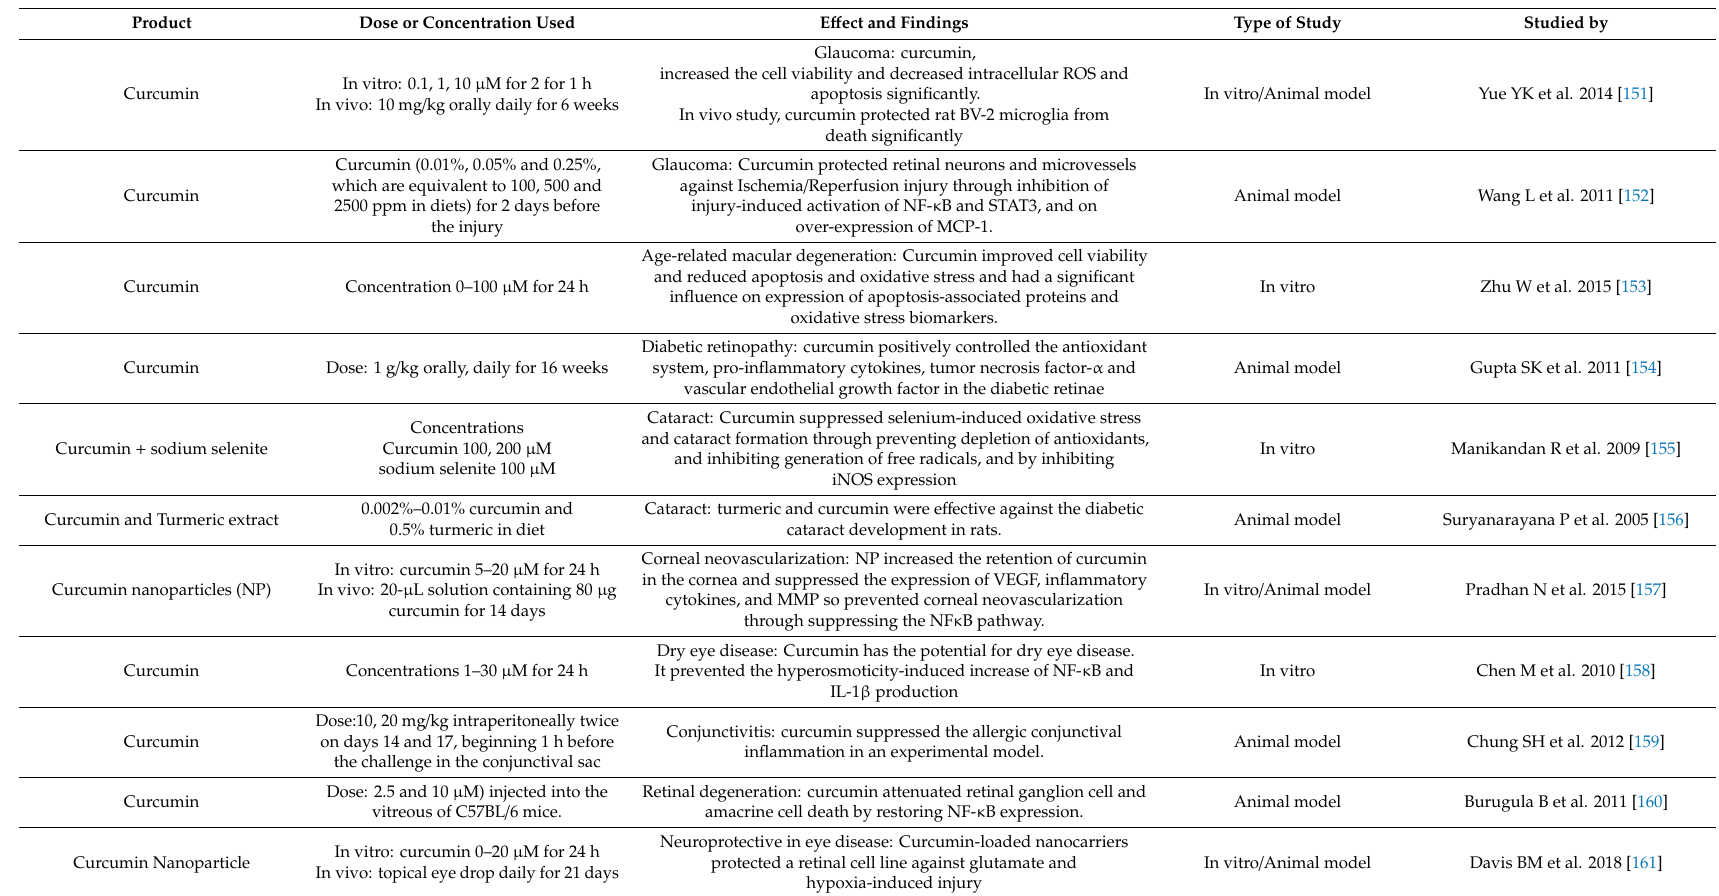
Table 7. E ff ect of Curcumin in eye